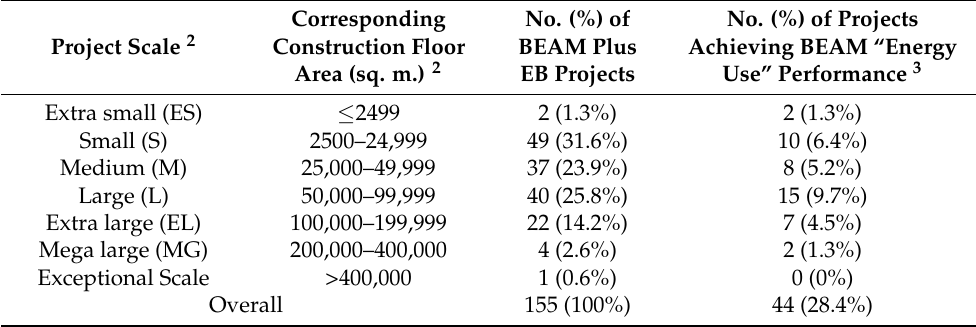
Table 7. Assessed GFAs of BEAM-certified projects (N = 155) 1